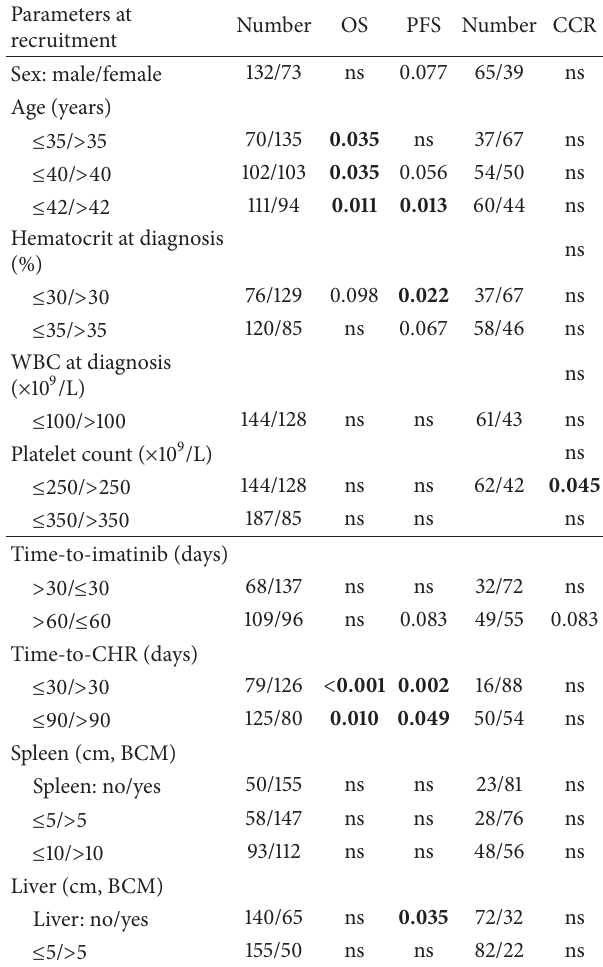
Table 2: Overall and progression-free survival (OS and PFS) of all 272 patients and of 205 patients in chronic phase (CP).